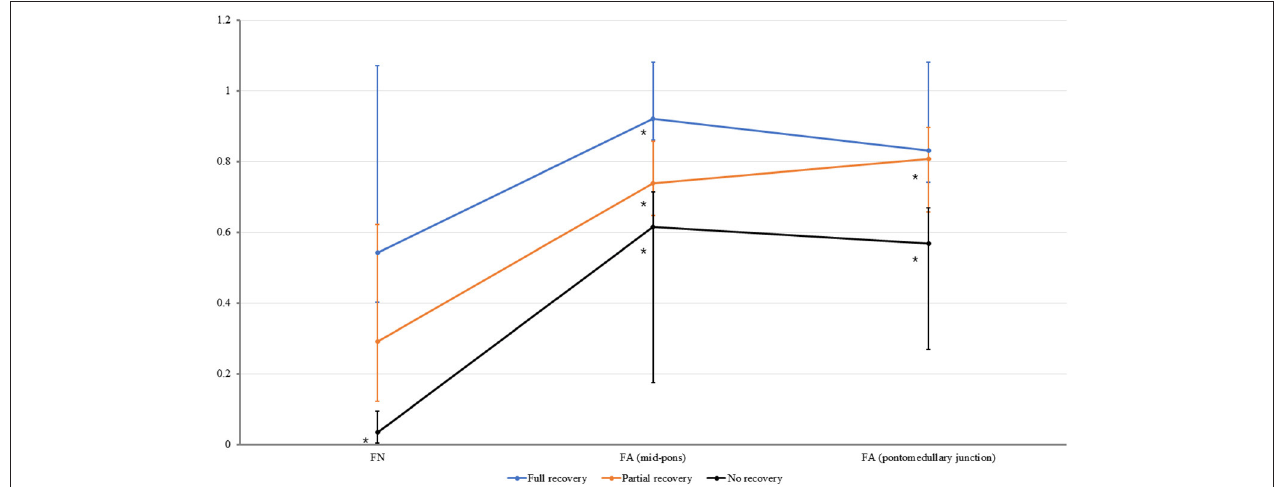
FIGURE 3 | The normalized fiber number (FN), fractional anisotropy (FA) at the mid-pons, and FA at the pontomedullary junction of the corticospinal tract in all groups. The median values are shown as dots. For all values, the error bar shows the interquartile range between the first and third quartiles. *The FN value for no recovery group was lower than those that for full recovery group ( P ≤ 0.0166). *The FA (mid-pons) value for the full recovery group was higher than those for the other two groups ( P ≤ 0.0166), and the FA (mid-pons) value for the partial recovery group was higher than that for the no recovery group ( P ≤ 0.0166). *The FA (pontomedullary junction) value for the full recovery group and partial recovery group were higher than that for the no recovery group ( P ≤ 0.0166, respectively). The FA (pontomedullary junction) value for the full recovery group and that for partial recovery group were not significantly